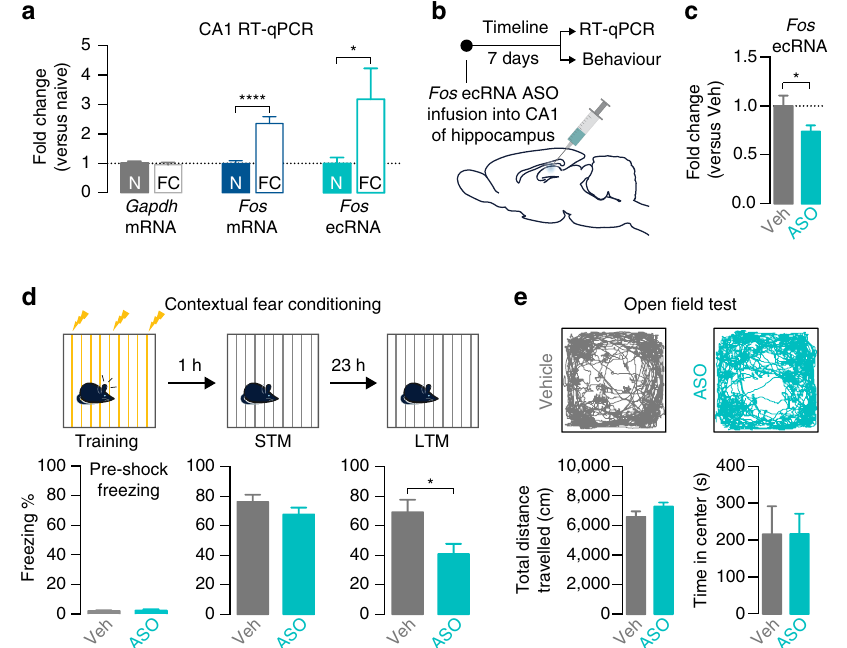
Figure 7 | Fos ecRNA is induced by behavioural experience and modulates memory formation. ( a ) Contextual fear conditioning is associated with increased Fos mRNA and Fos ecRNA in the CA1 subregion of the hippocampus, as compared with experimentally naı¨ve controls (N ¼ naı¨ve, FC ¼ fear conditioned; n ¼ 16 per group; Mann—Whitney U test, U ¼ 15 and P o 0.0001 for Fos mRNA, U ¼ 73 and P ¼ 0.038 for Fos ecRNA). Area CA1 was subdissected from total hippocampus 1h following contextual fear conditioning. ( b ) Experimental timeline for Fos ecRNA ASO experiments in vivo . ( c ) Fos ecRNA ASO treatment decreased Fos ecRNA expression in the CA1 of the hippocampus ( n ¼ 8–9 per group, unpaired Student’s t -test, t 15 ¼ 2.173, P ¼ 0.0462). ( d ) Top, contextual fear conditioning design. Bottom, Fos ecRNA ASO treatment impaired long-term memory but did not alter baseline freezing or short-term memory ( n ¼ 8–9 per group; STM unpaired Student’s t -test, t 15 ¼ 1.245, P ¼ 0.23; LTM unpaired Student’s t -test, t 15 ¼ 2.640, P ¼ 0.0186). ( e ) Open field test. Top, representative traces showing animal location during 30min test session. Fos ecRNA knockdown did not affect total distance travelled (bottom left; unpaired Student’s t -test, t 14 ¼ 1.517, P ¼ 0.1514) or time spent in the center of an open field test (bottom right;